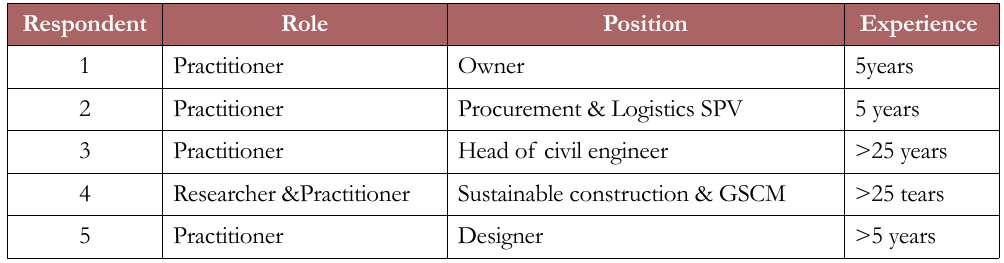
Table 1. The characteristics of respondents